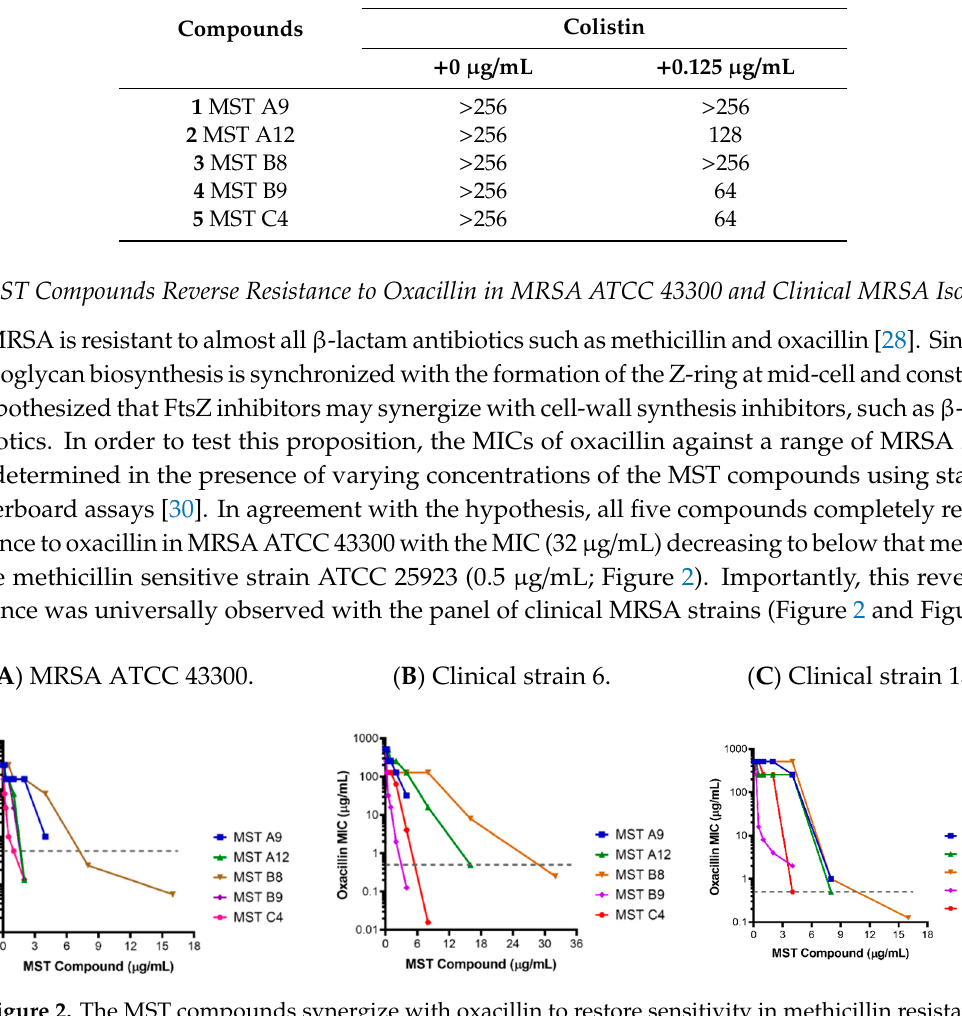
MIC, µ g / mL Colistin